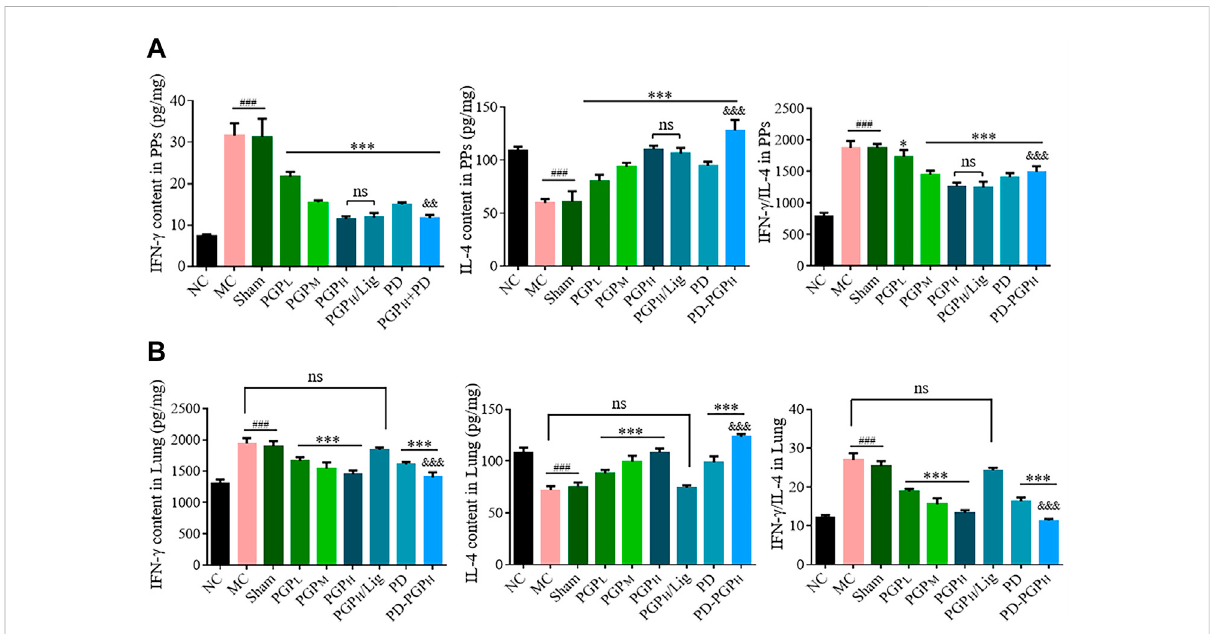
FIGURE 5 ELISA results (A1 and B1) and ratios analysis (A2 and B2) of IFN- γ and IL-4 contents in the PPs (A) and lung tissues (B) of CB rats, after 90 min intestinal perfusion of PGP and PD (groups situ PGP L/M/H , situ PD, situ PD-PGP H ), with (group situ PGP H /Lig) or without mesenteric lymphatic vessel ligation. IFN- γ andIL-4 contentsinPPsandlung tissuesfromnormal (groups situ NC),model(group situ MC),andsham-operatedmodel(group Sham) ratsweresetasthecomparison.(Dataareexpressedasmean±SD( n =6);* p < 0.05and*** p < 0.001 versus MCgroup; ### p < 0.001 versus NC group; &&& p < 0.001 versus PD